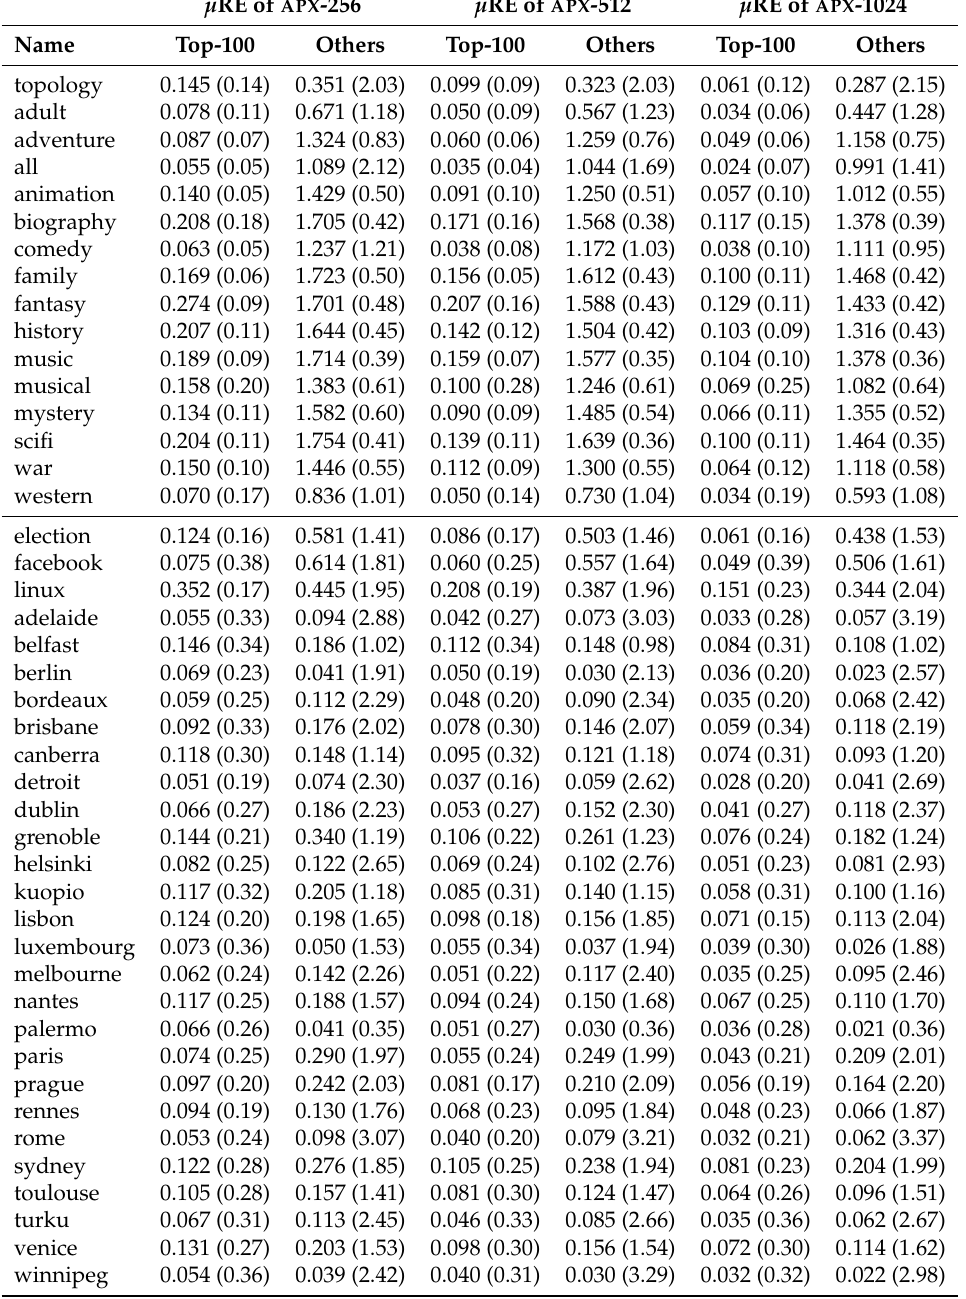
Table A2. Average RE (and coefficient of variation) for the top-100 nodes (according to the exact ranking) and for the remaining